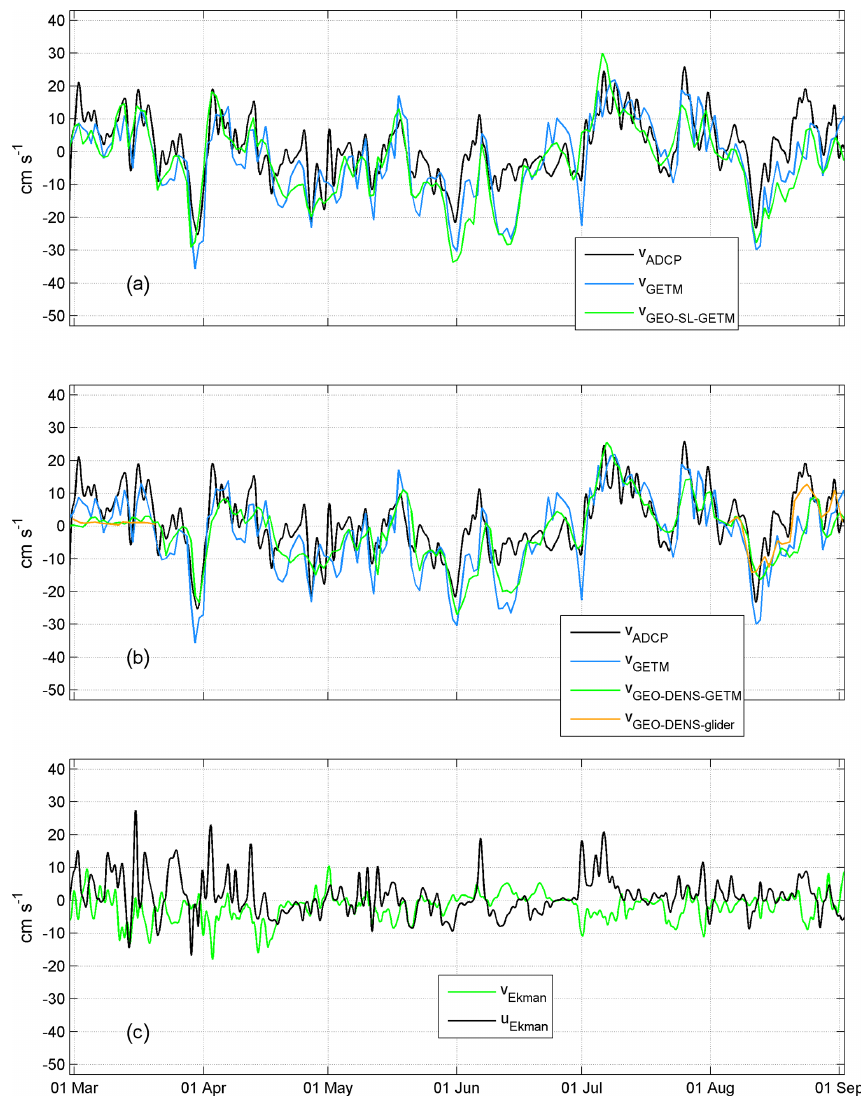
Figure 5. Temporal courses of (a and b) the current velocity v component (positive northward) measured by ADCP ( V ADCP ) and the simulated v component ( V GETM ) estimated from the GETM sea level data ( V GEO-SL-GETM ), from temperature and salinity data collected by a glider ( V GEO-DENS-glider ), and from temperature and salinity data simulated by GETM at 11m depth ( V GEO-DENS-GETM ). Mean Ekman current u component (positive eastward) and v component ( U Ekman as well as V Ekman ) in the depth range 0–11m (c) . Time series are shown from March to September 2020 at the ADCP location (see Fig. 1b and